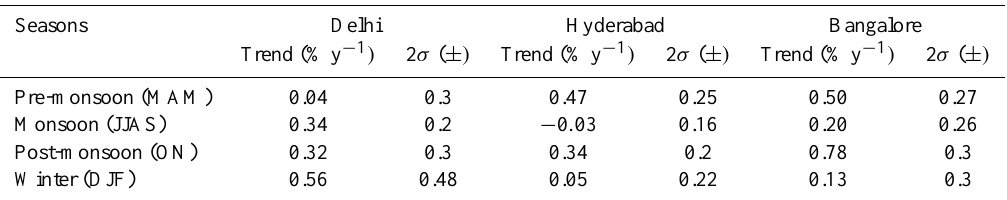
Table 2. Trend regression coefficients (% per year) for tropospheric ozone residue (TOR) over the three tropical inland cities Delhi, Hyder- abad and Bangalore for the period 1979–2005.